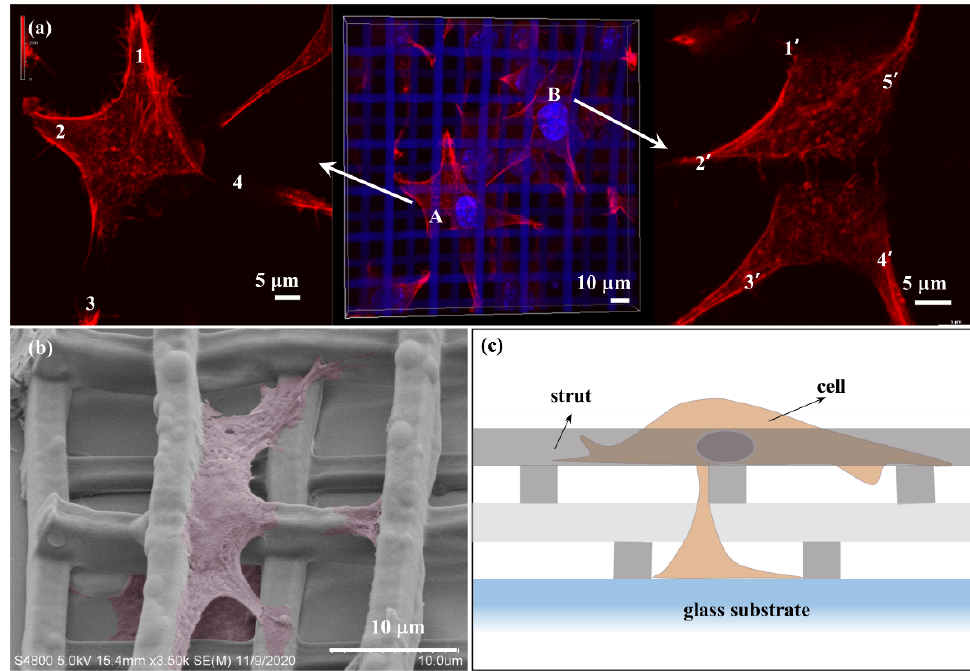
Figure 7. ( a ) “Starfish-like” F-actin with more lamellipodia on the scaffold with 20 μ m strut spacing. ( b ) SEM image of lamellipodia extending from the cell body on 20 µ m scaffold. ( c ) Schematic diagram ( b ) SEM image of lamellipodia extending from the cell body on 20 μ m scaffold. ( c ) Schematic dia- gram of cell spreading in 3D microscaffold. of cell spreading in 3D